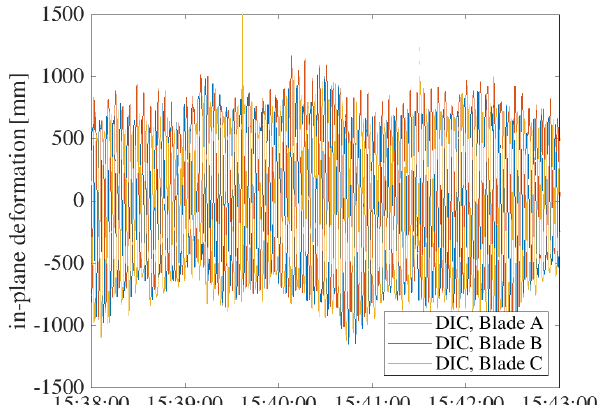
Figure 16. IP DIC signal of all blades.